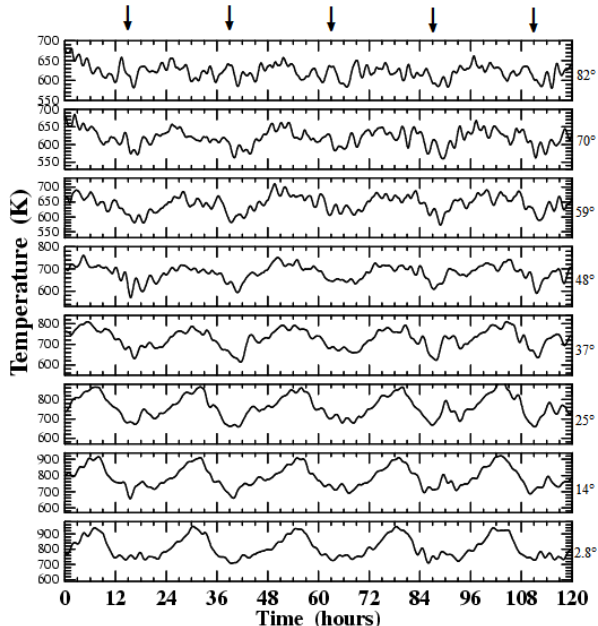
Fig. 6. Temperature variations at a constant-pressure surface ( ∼ 310km) during 1–5 December in the Northern (winter) Hemi- sphere at 135 ◦ E longitude and 82 ◦ N, 70 ◦ N, 59 ◦ N, 48 ◦ N, 37 ◦ N, 25 ◦ N, 14 ◦ N, and 2.8 ◦ N latitudes from the top to bottom, respec- tively. The values on the abscissa axis indicate hours from 00:00UT on 1 December. The five arrows at the top of the figure denote the times corresponding to midnight